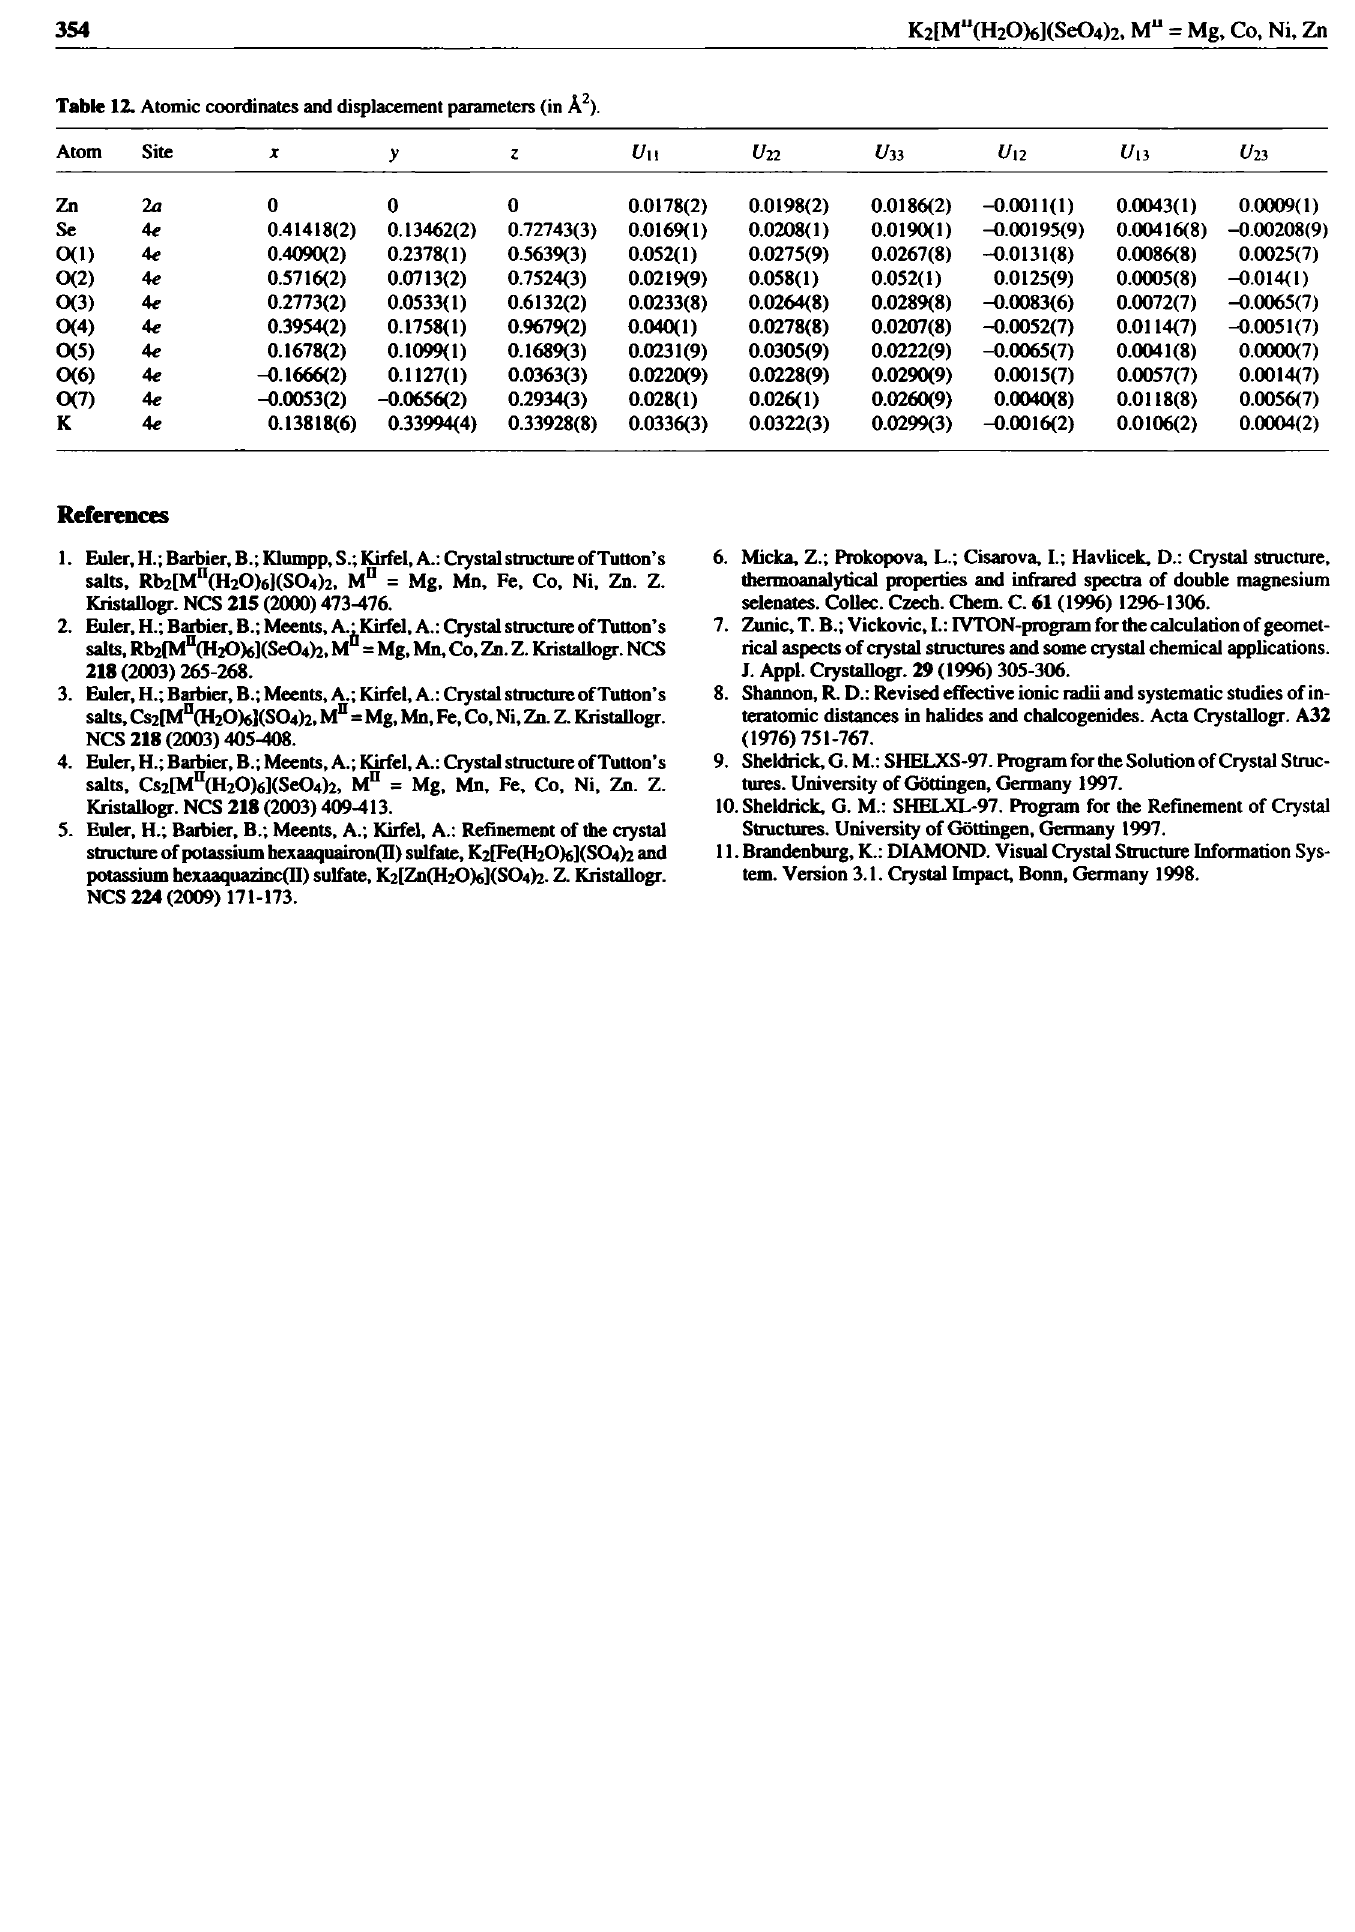
Table 12. Atomic coordinates and displacement parameters (in Â 2